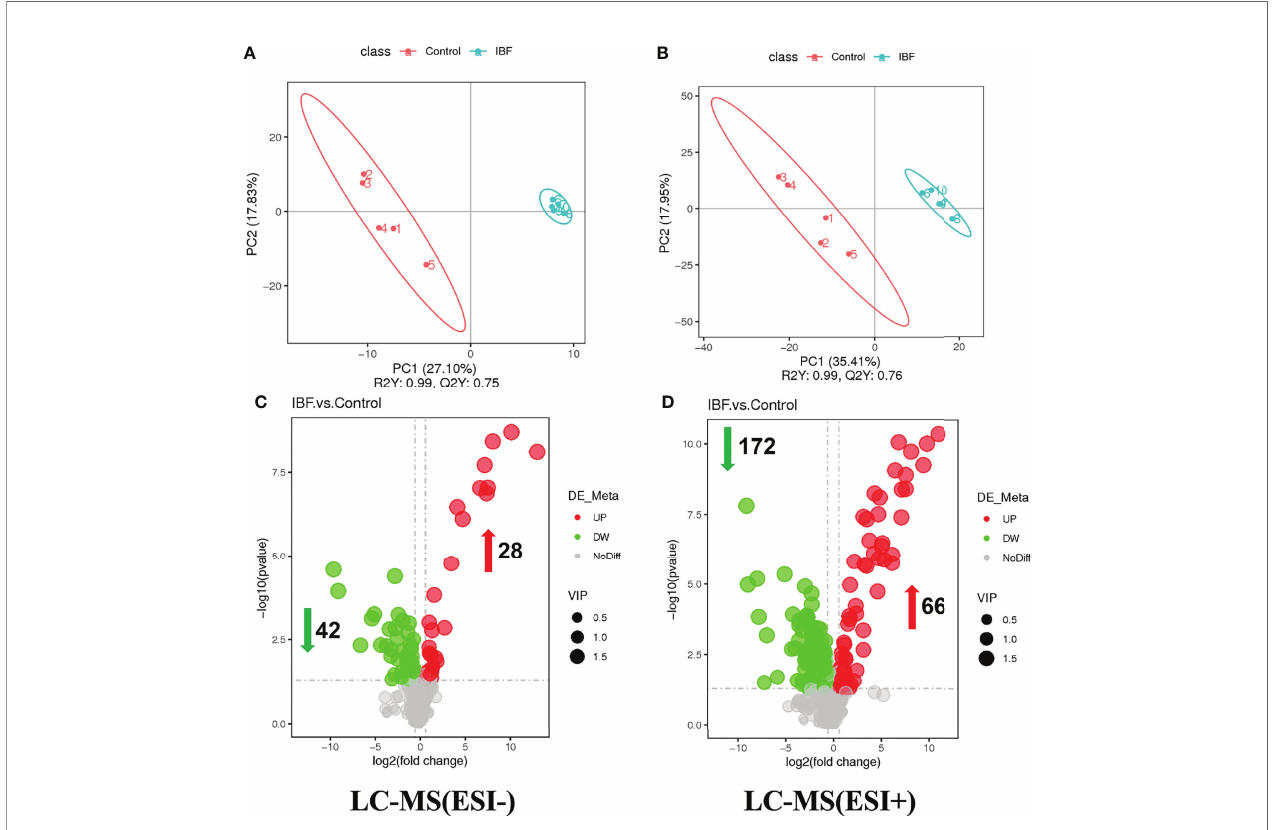
FIGURE 4 | Comparison of ileal chyme metabolome between the birds in IBF and control group. The analysis of panel (A) and panel (B) were based on the discriminant analysis of partial least squares (PLS-DA). The results in anion mode were showed in panel (A) and panel (C) , and the results of cation mode were arranged in panel (B) and panel (D) , n=